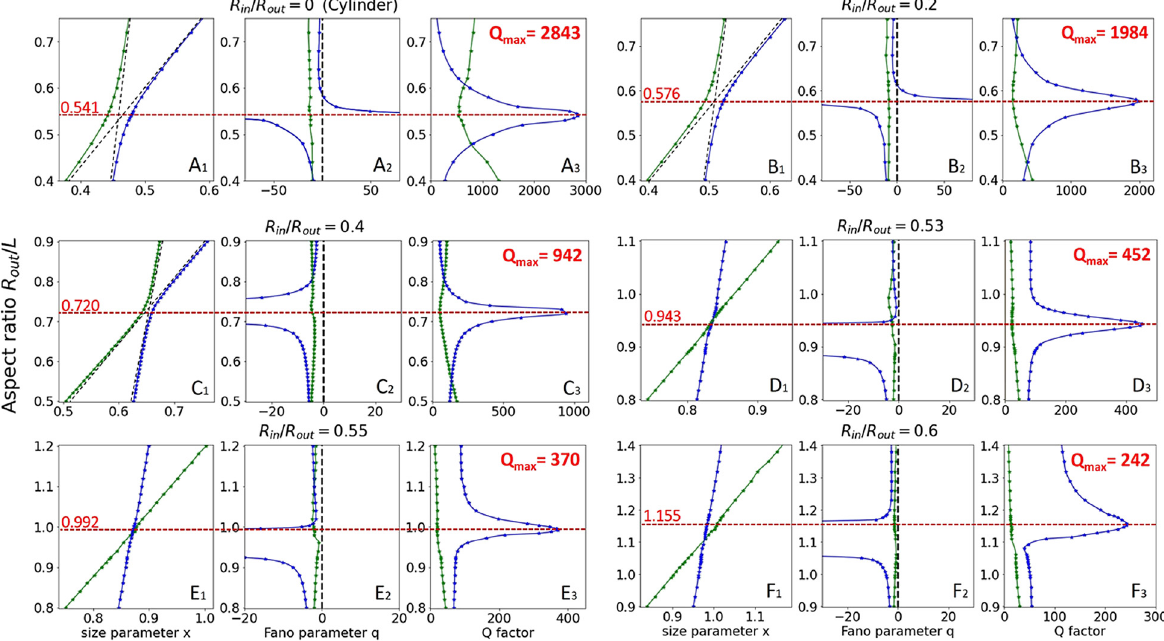
Figure 4: Results of treatment of the SCS spectra (for harmonic m = 1) using the Fano formula (6) for the low-frequency and high-frequency modes. (Mie-type mode) and TM (Fabry–Perot-type mode). (A2)–(F2) evolution of the Fano asymmetry (A1)–(F1) frequencies of the TE 1 , 1 , 0 1 , 1 , 1 parameter q . (A3)–(F3) evolution of the quality-factor Q . Panels with index (A) correspond to the cylinder, and those with indexes (B)–(F) ∕ R = 0 . 2 , 0 . 4 , 0 . 53 , 0 . 55 , 0 . 6, correspond to rings with the ratio R in out